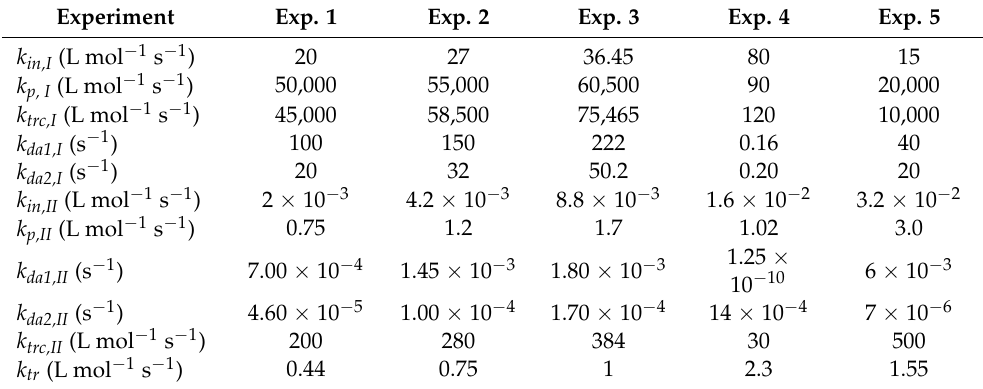
Table 2. Estimated kinetic rate constants for the β -myrcene CCTP. Experiment